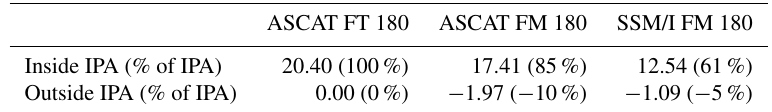
Table 3. Comparison of satellite data results based on a 180-day threshold with permafrost extent from Brown et al. (1997). Covered area in percent inside and outside permafrost regions is provided. FT – days identified as frozen without melting snow are used; FM – days with melting snow are considered to be frozen ground with Metop ASCAT.